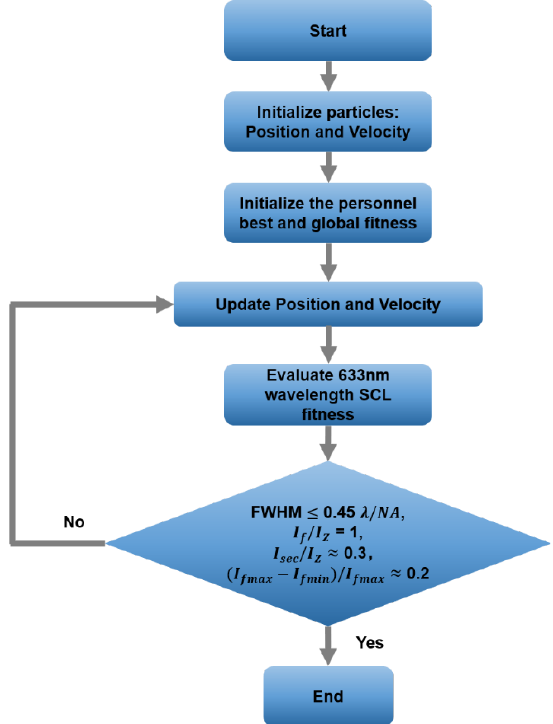
Figure A1. The optimization procedure for shaping sub-diffraction-limited transverse optical needle by an elliptical SCL. Table A1. The position information of each belt for elliptical supercritical